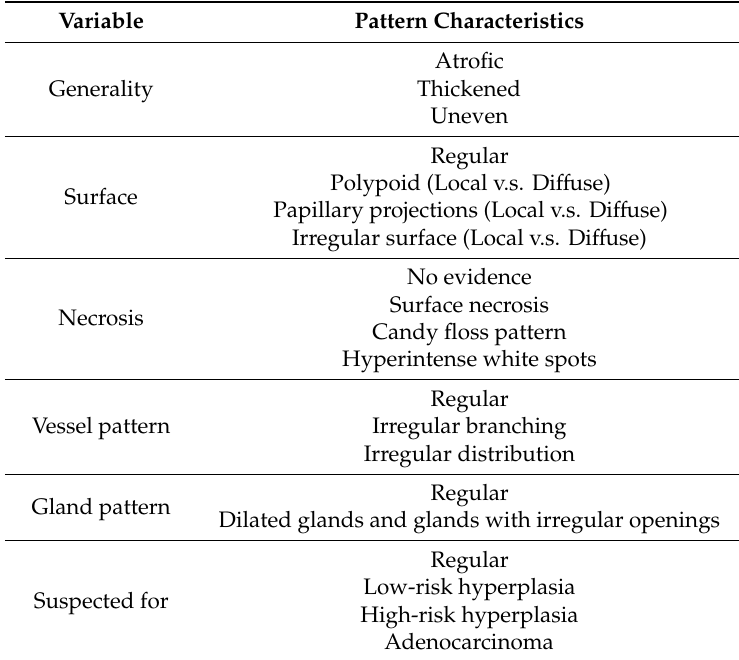
Table 1. Endometrial evaluation during